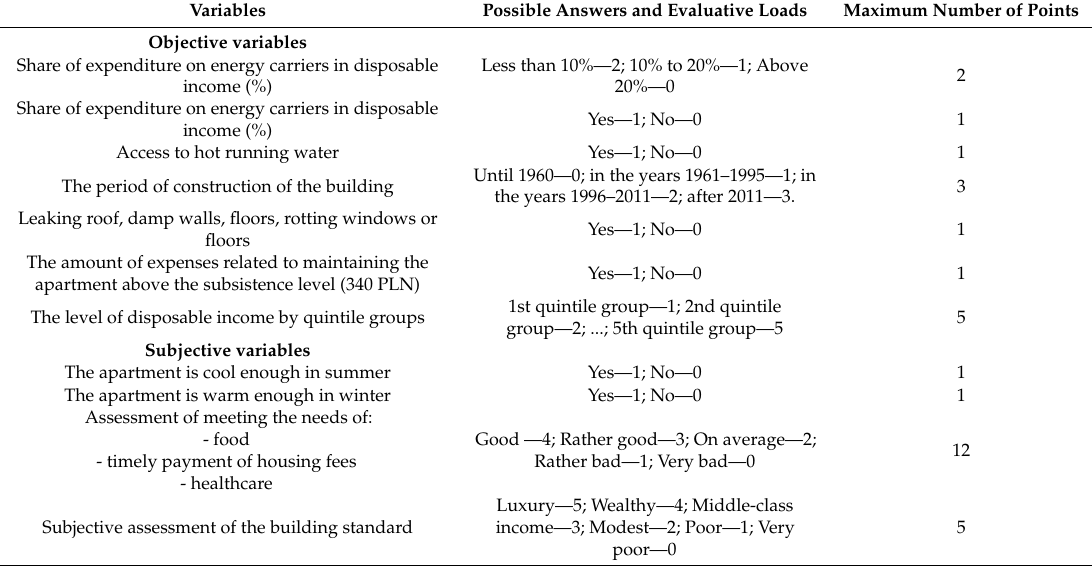
Table 1. Aggregate index of energy poverty (energy comfort) for one-person